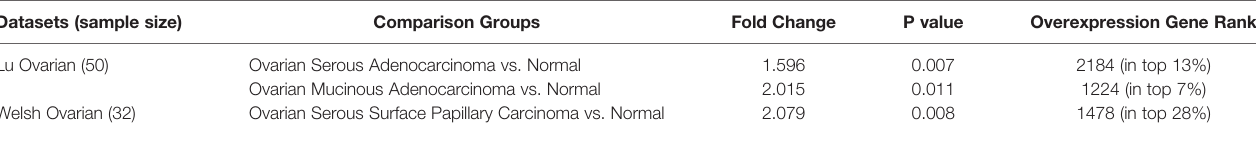
TABLE 1 | Detailed information about the 3 public expression datasets of Oncomine database about PFKFB3 in ovarian cancer. Datasets (sample